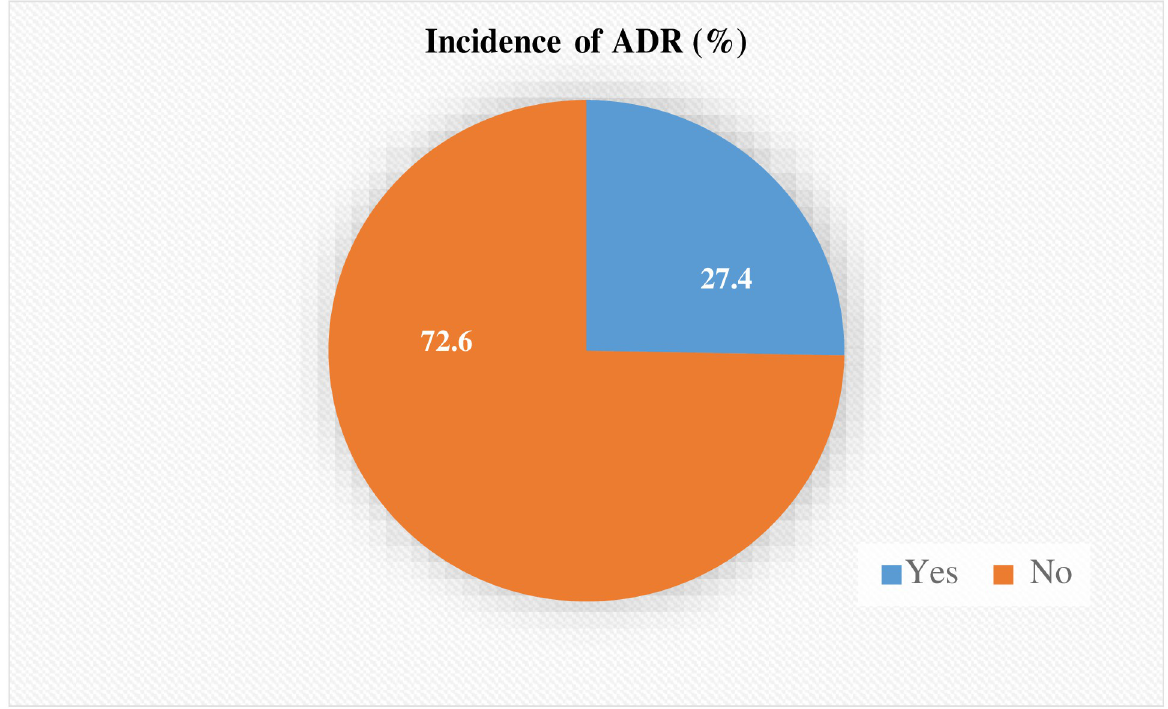
Fig 1. Incidence of ADR among admitted patients at the UoGCSH medical ward from May 28 up to July 26, 2022 (N =